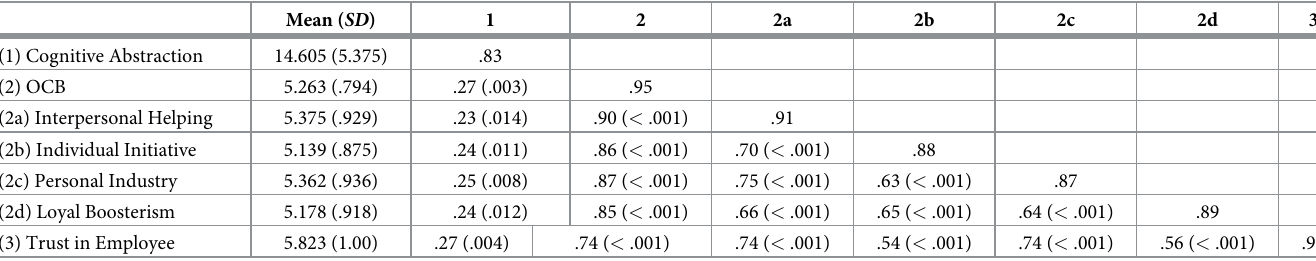
Table 2. Means, standard deviations, reliabilities, and correlations between Study 1 variables.